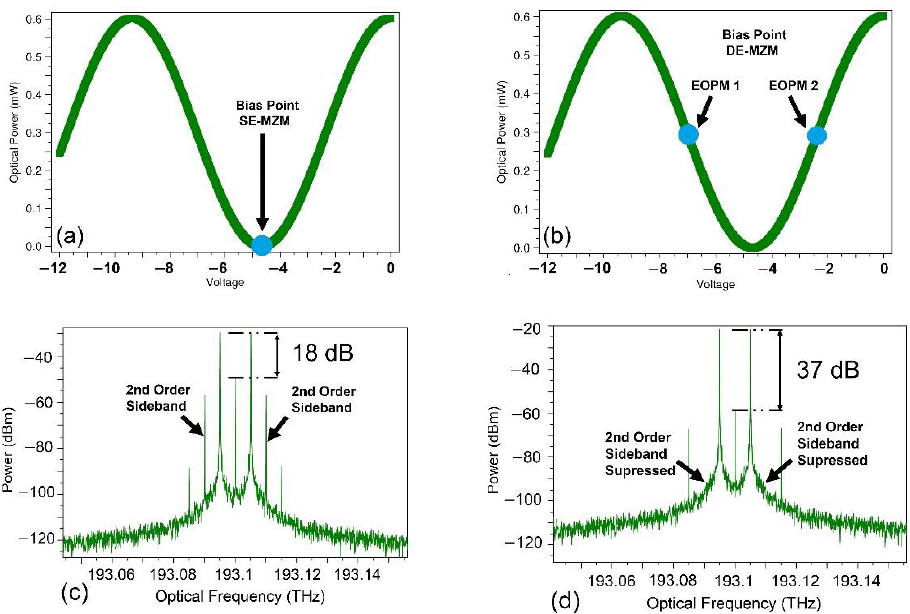
Figure 4. ( a ) Characteristic curve of the SE-MZM structure. ( b ) Characteristic curve of the DE- MZM structure. ( c ) DSB-SC spectrum of the SE-MZM approach. ( d ) DSB-SC spectrum of the DE-MZM